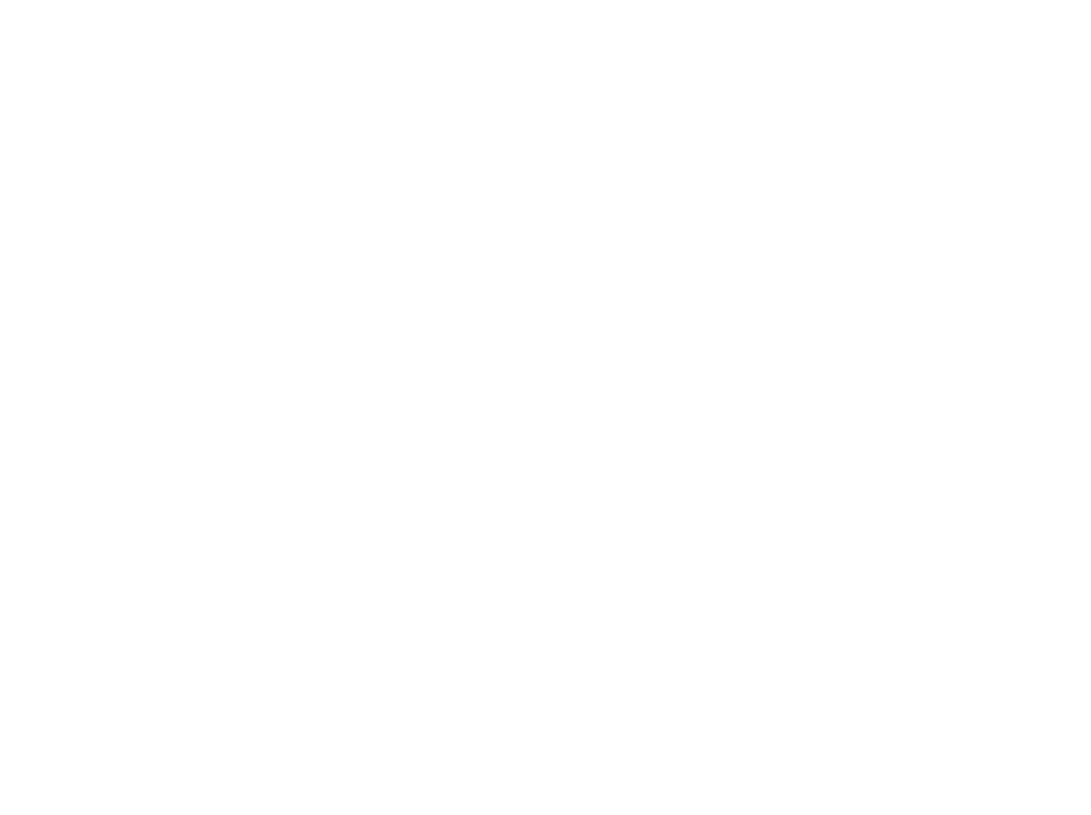
Figure 7. The experimental setup. BS, beam splitter; HWP, half-wave